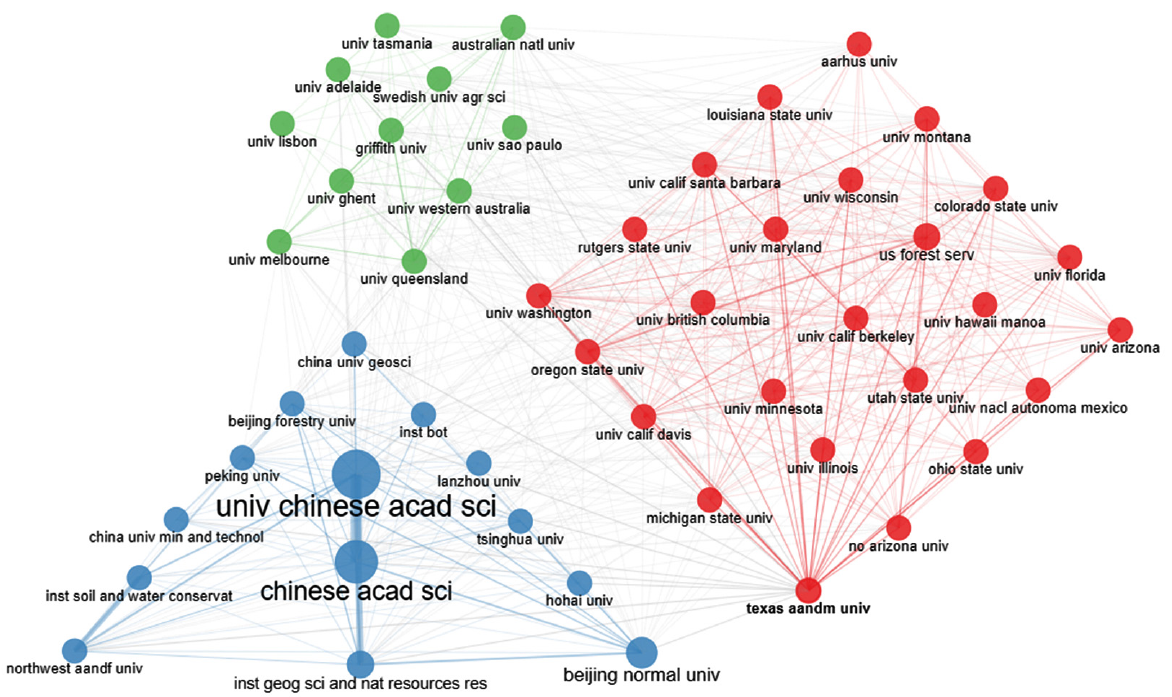
Figure 5. Collaboration network of institutions publishing articles in the field of ecological restoration from 1990 to 2022.